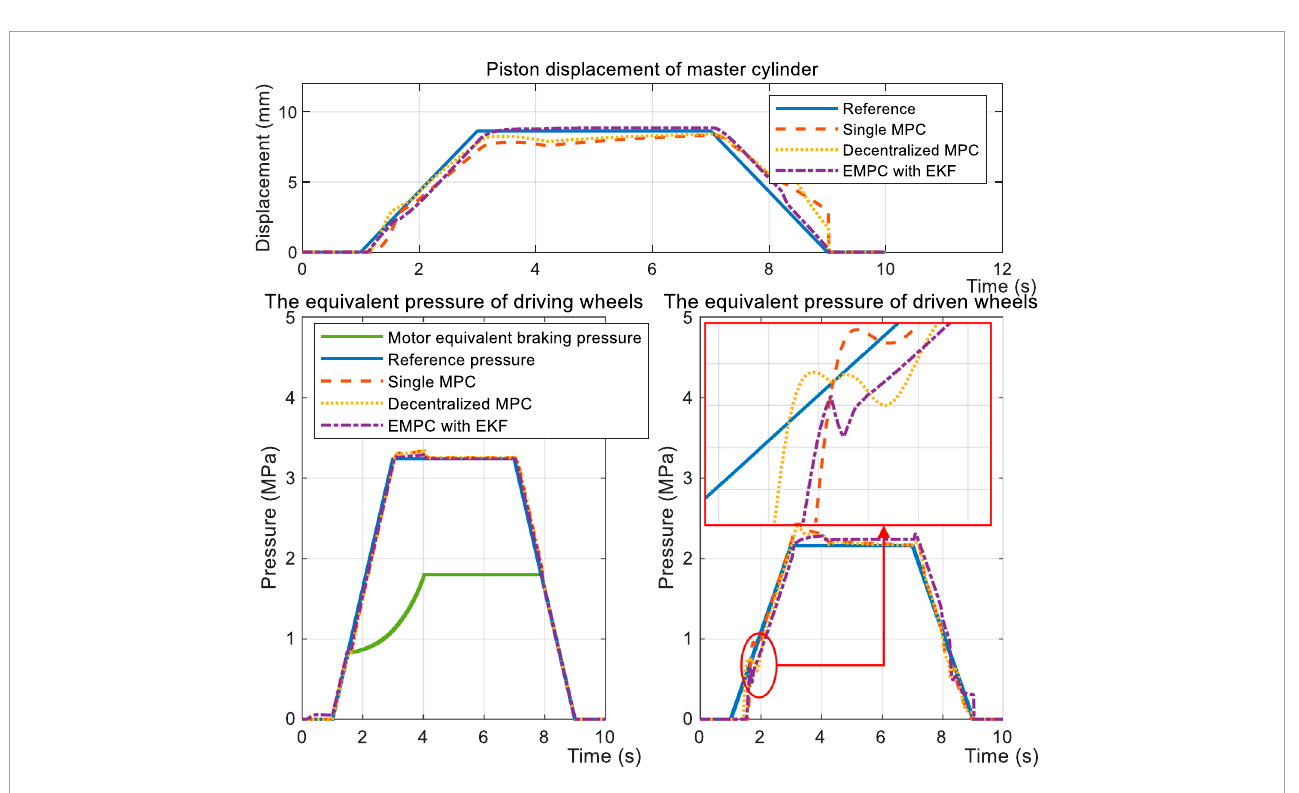
FIGURE 14 Regenerative simulation results of the test